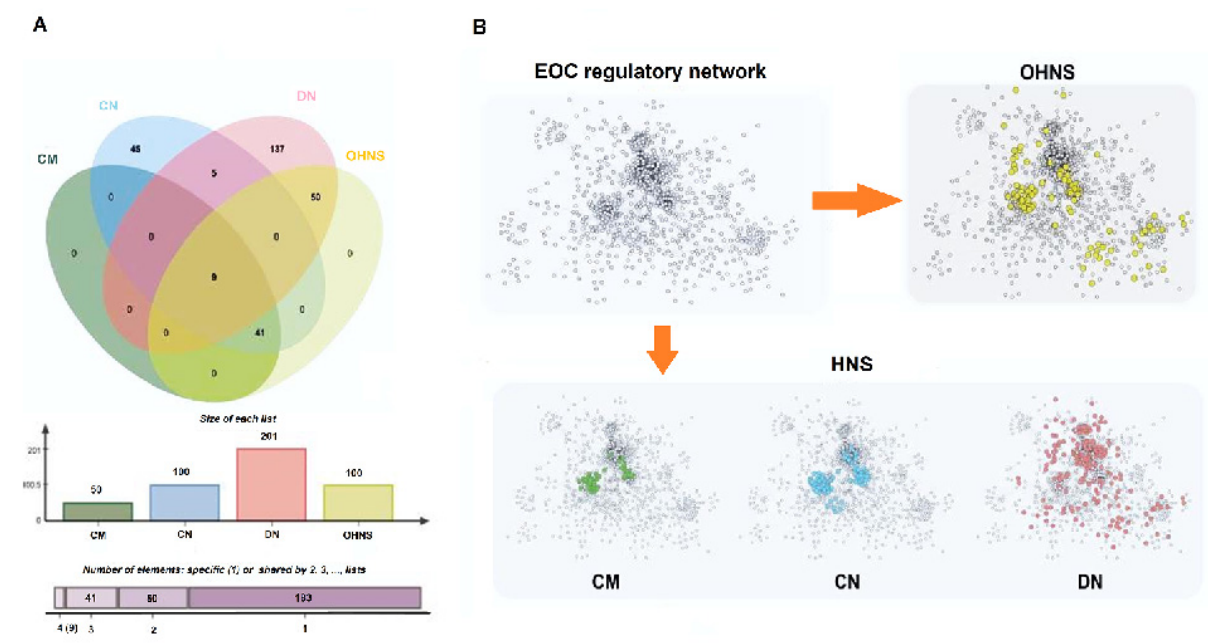
Figure 1. Distribution map of the HNS: ( A ) the Venn diagram represents the relationships among the HNS. Charts showing the list size, and the intersection size repartition are located underneath the diagram; ( B ) green represents the CM (core module), blue represents the CN (core nodes), pink represents the DN (driver nodes), and yellow represents the OHNS.